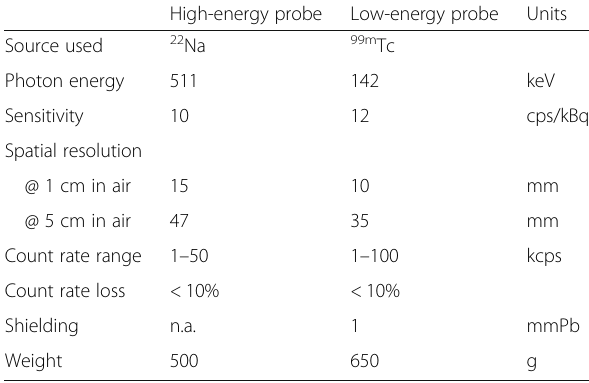
Table 2 Comparison between high-energy probe and a